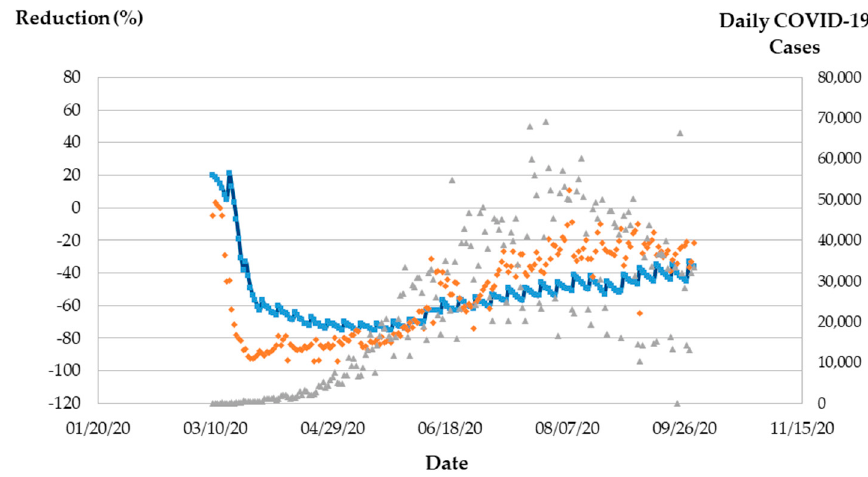
Figure 5. Percentage reduction (%) in traffic congestion (red) and urban transport use (blue), com- pared to the number of daily COVID-19 infections (gray). Santiago, Chile.